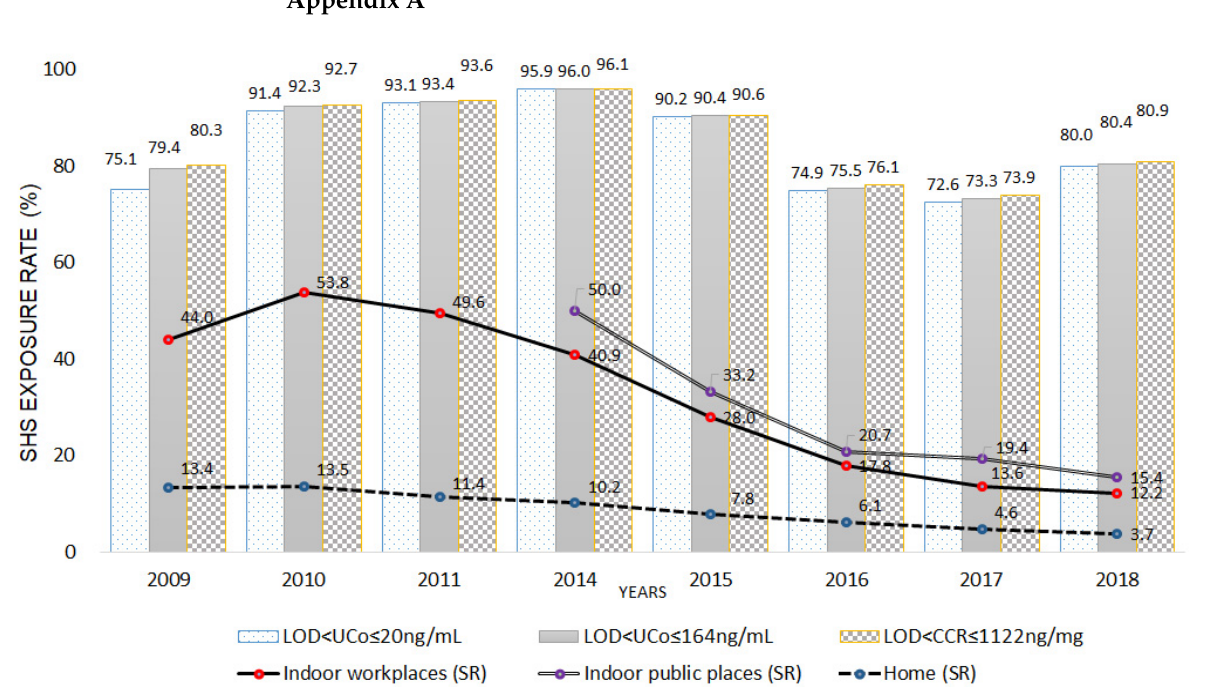
Figure A1. Secondhand smoke exposure rate by year (2009–2018); exposure rates at home, indoor workplaces, and public places, as self-reported measurements. LOD, limit of detection; UCo, urine cotinine; CCR, cotinine–creatinine ratio. In 2012–2013, UCo was not investigated; the survey was resumed from 2014. Kang 19 and Kim’s 39 studies selected the cutoff point.